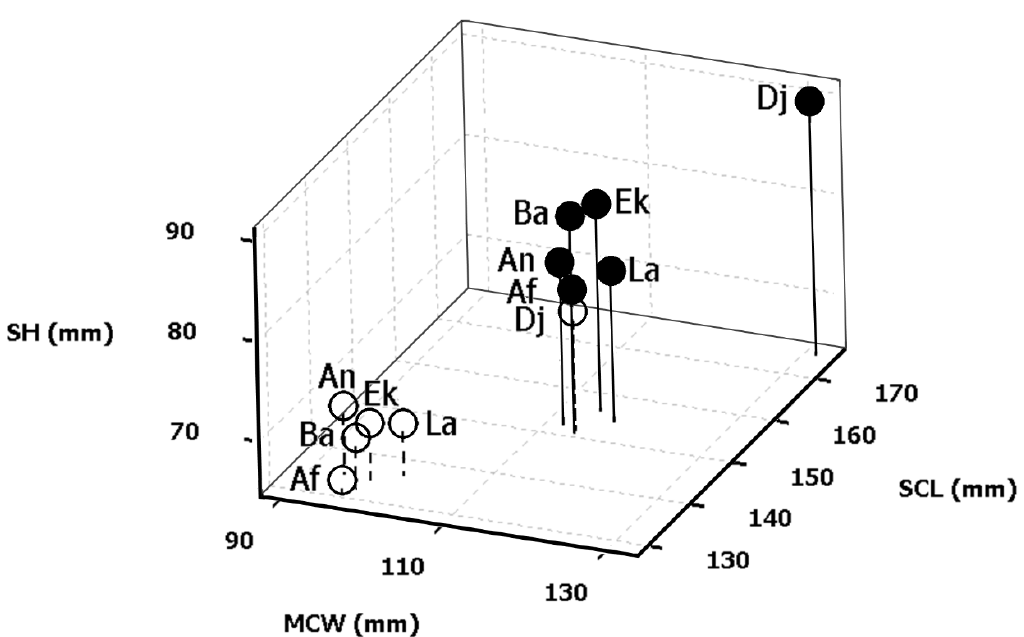
Figure 3. Three-dimensional scatterplot of body size distances between localities and sexes of Algerian T. graeca . Black circles with continuous sticks are means of females. White circles with discontinuous sticks are means of males. SCL — straight carapace length; MCW — mid-body carapace width; SH — shell height; Ek — El Kala; An — Annaba; Ba — Batna; Dj — Djelfa; La — Laghouat; Af — Aflou. Table 2. Sexual and geographic differences in body size and shell shape among adults of Algerian T. graeca . F (m − 1, e) and p values for body size are from ANOVA, and for shell shape are from ANCOVA ( e , error degrees of freedom; Sample size ( n ) = e + m (number of groups being compared) + 1 (if the ANCOVA test case); a = One-way interaction; b = Two-way interaction; * = p < 0.05; ** = p < 0.01; *** = p < 0.001).